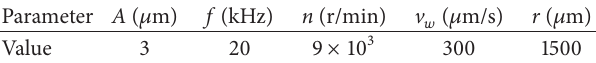
Figure 3: Instantaneous abrasive cutting thickness (ℎ) about 𝑡 during half a wheel rotating cycle. Table 1: Simulation test